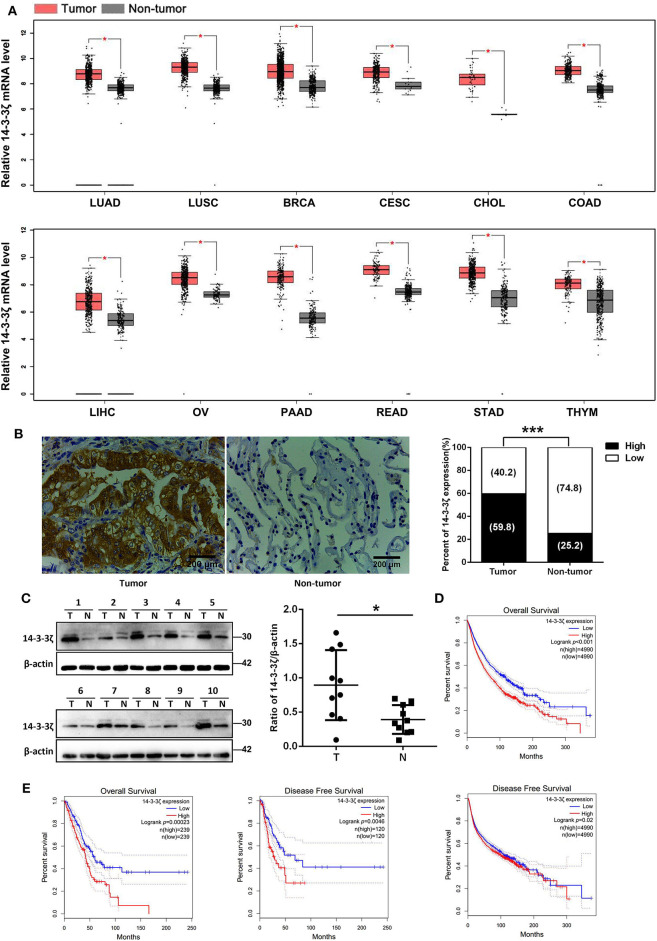
Elevated 14-3-3ζ expression positively correlates with poor prognosis of lung adenocarcinoma (LUAD) patients. (A) Relative mRNA levels of 14-3-3ζ in different tumors were analyzed by Gene Expression Profiling Interactive Analysis (GEPIA). *p < 0.05 (B) Representative immunostaining images for 14-3-3ζ expression in 128 human LUAD tissues with epidermal growth factor receptor (EGFR) mutations (tumor) and 31 non-tumoral lung tissues (non-tumor). Original magnification, ×400; Scale bar = 200 μm. Histogram showing percentages of 14-3-3ζ expression in tumor and non-tumor tissues. ***p < 0.001 (C) Western blot analysis of 14-3-3ζ expression in lysates originating from 10 human LUAD samples with EGFR mutant (T) and matched adjacent normal tissues (N). Right panel: quantification of relative expression levels of 14-3-3ζ. β-actin was used as a loading control. *p < 0.05. (D) Kaplan–Meier analysis of overall and disease-free survival (DFS) for high and low 14-3-3ζ expression levels in pancancer determined by GEPIA. (E) Kaplan–Meier analysis of overall and DFS for high and low 14-3-3ζ expression levels in LUAD determined by GEPIA.